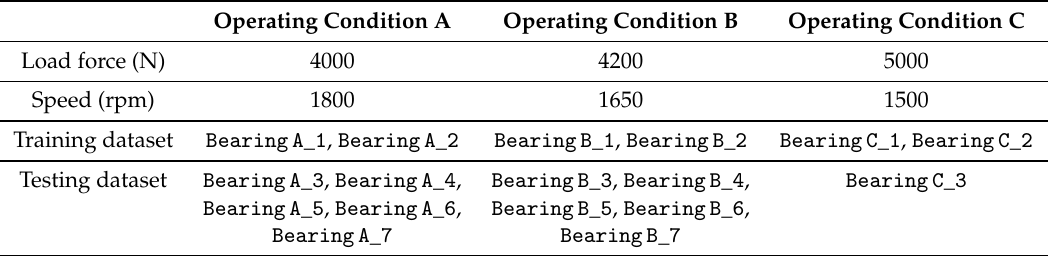
Table 2. Specifications of the experimental data.